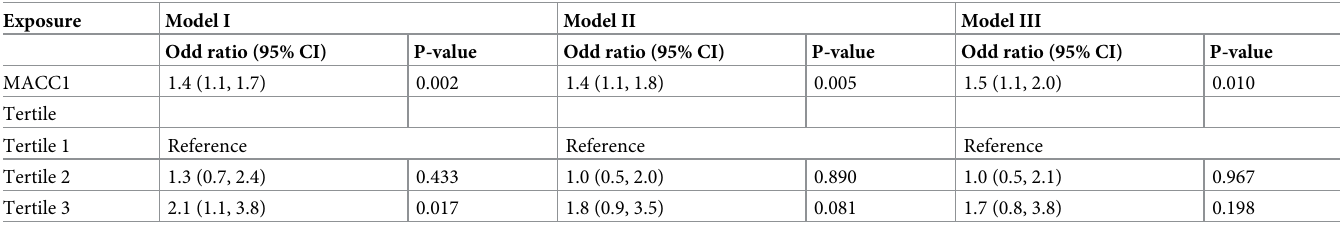
Table 5. Effect of MACC1 expression on lymphatic metastasis (N =